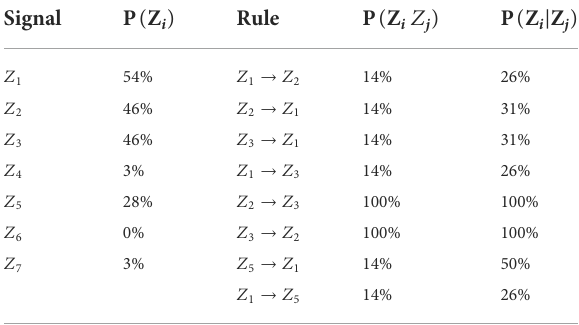
TABLE 5 Monthly distribution probability of wild fi res.